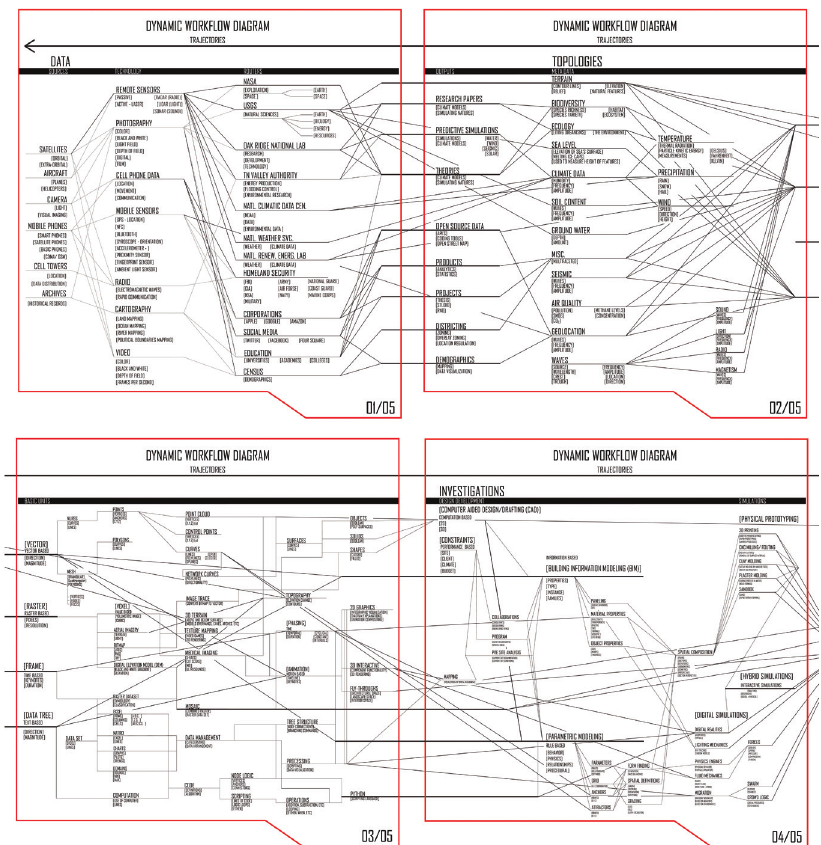
Figure 4: Enlarged segments of the workflow diagram. 1/5 outlines common sources of documentation streams. 2/5 outlines common output trajectories based on initial collected data. 3/5 maps common design visualization streams essential to generating design objectives. 4/5 maps popular digital tools used in formulating design